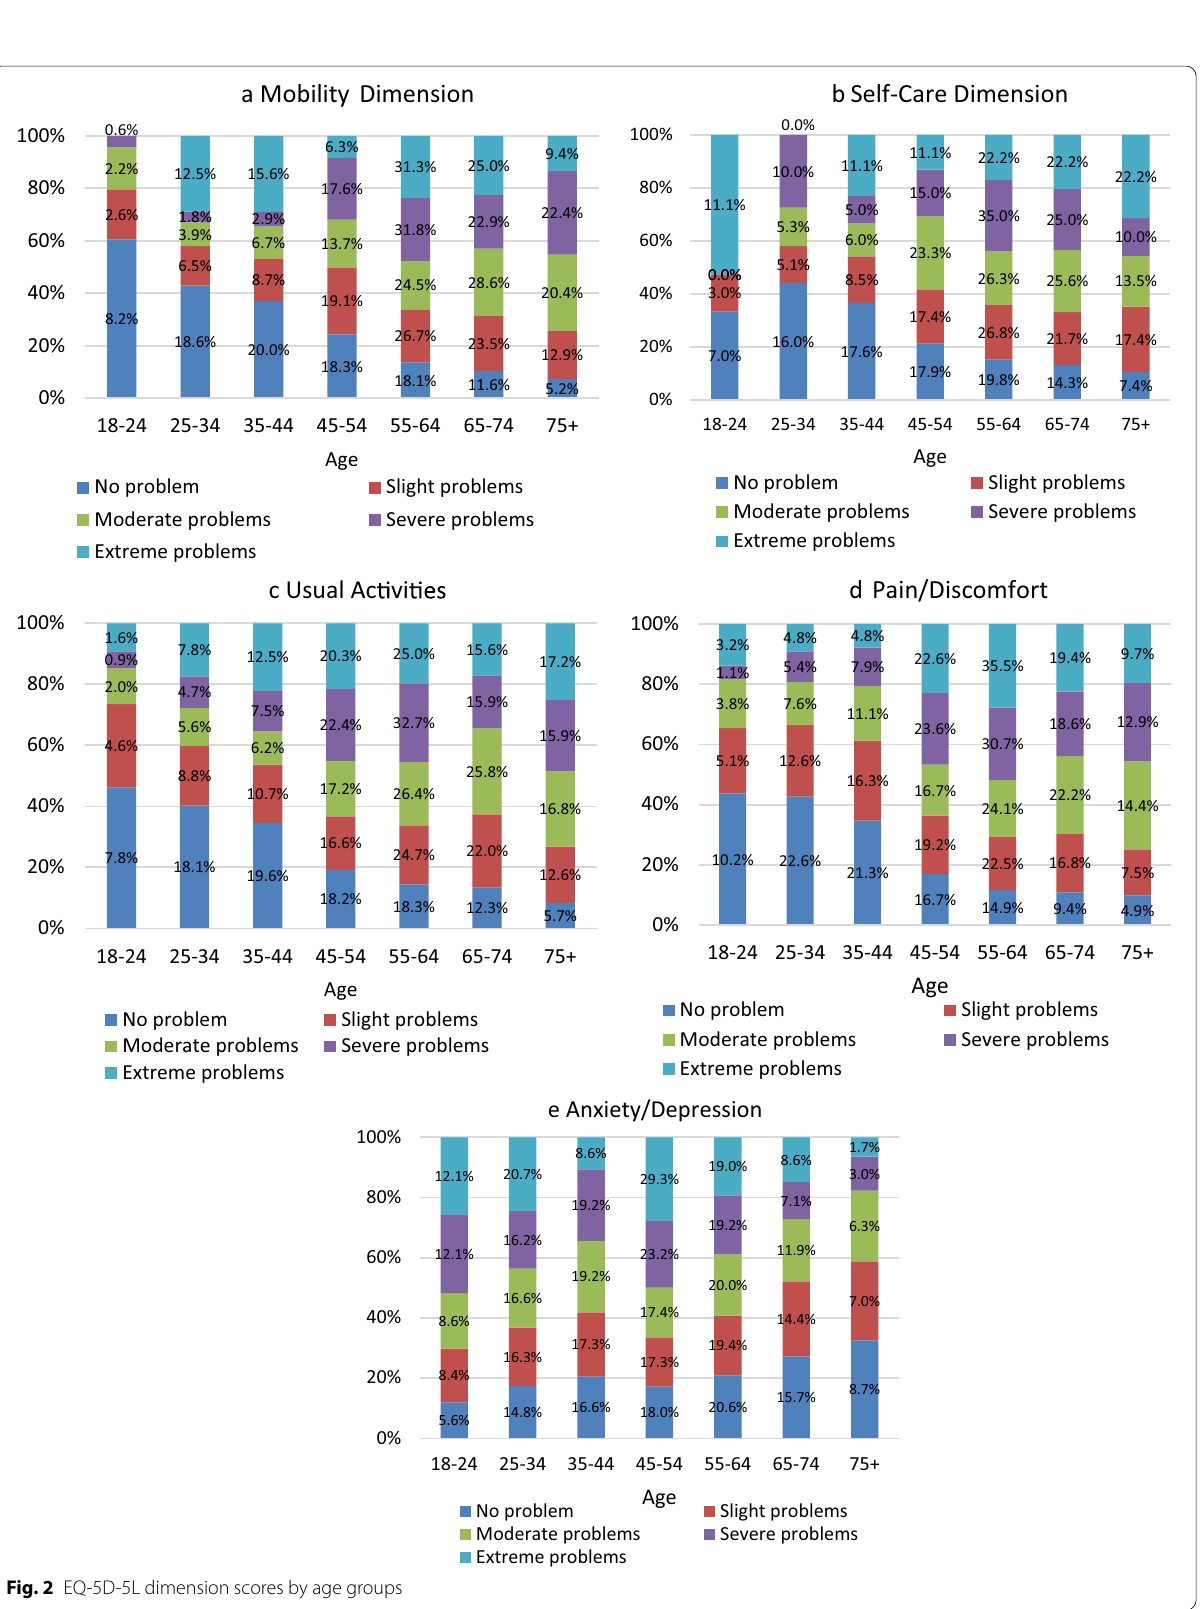
Fig. 2 EQ-5D-5L dimension scores by age